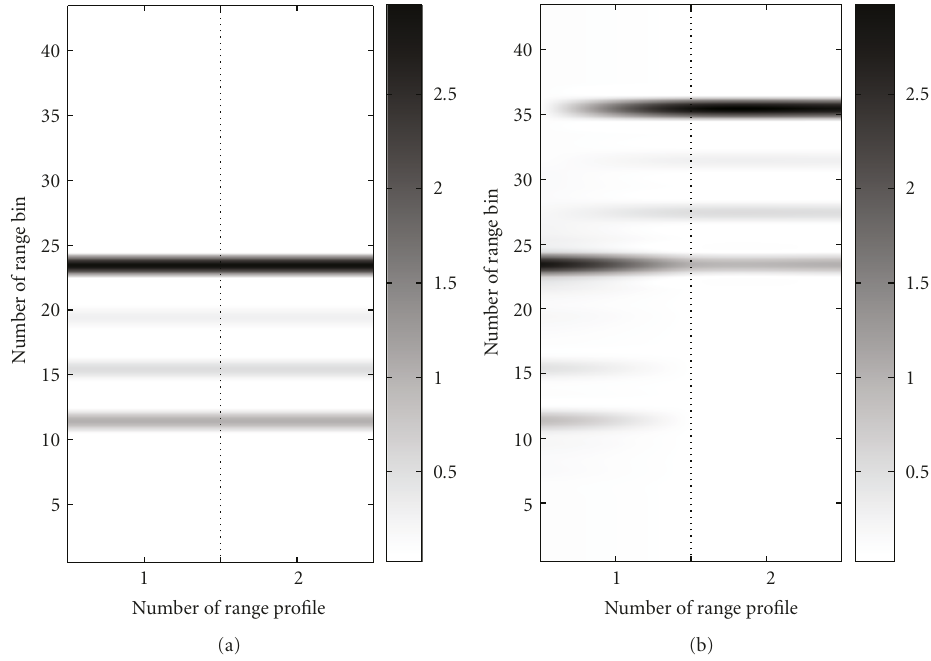
Figure 21: Alignment results for two simulated range profiles by applying (a) the proposed technique and (b) the global range alignment algorithm. The proposed method is robust against local maxima of its cost function. On the contrary, the global range alignment method may have convergence di ffi culties.